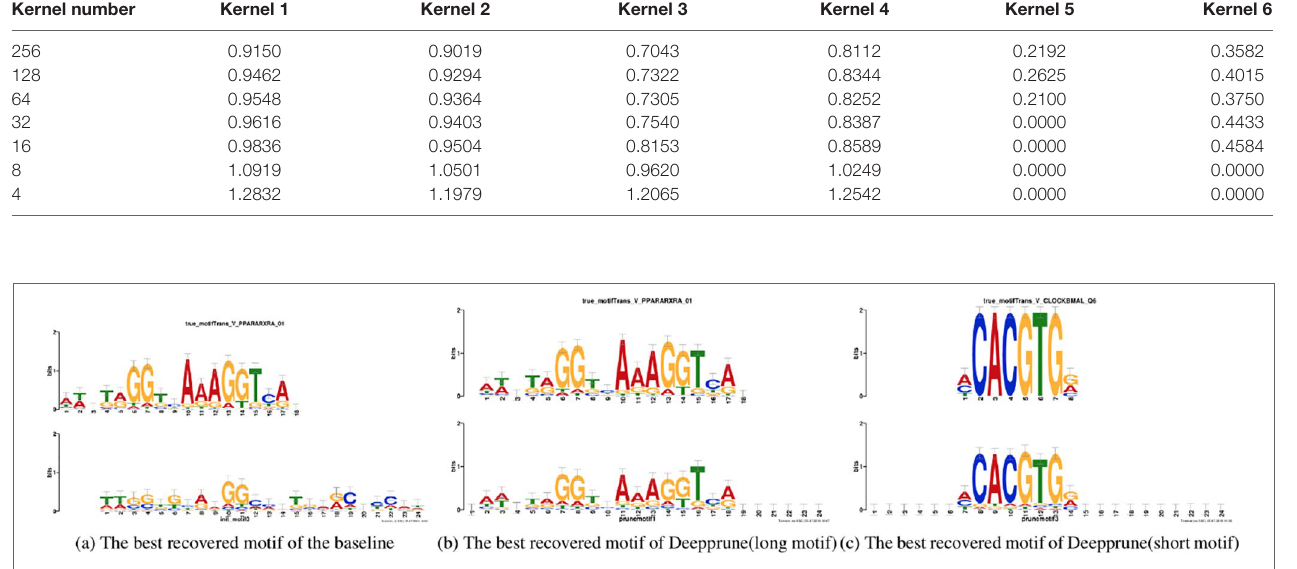
FIGURE 5 | Motifs recovered by our model (the last two) and by baseline (the first) aligned to the true given motifs (top row). Utilizing Tomtom algorithm, the E-values of the motifs recovered by Deepprune are 1.35 × 10 –23 , 2.27 × 10 –7 , respectively. At the same time, the ones recovered by baseline are 1.64 × 10 –2 .